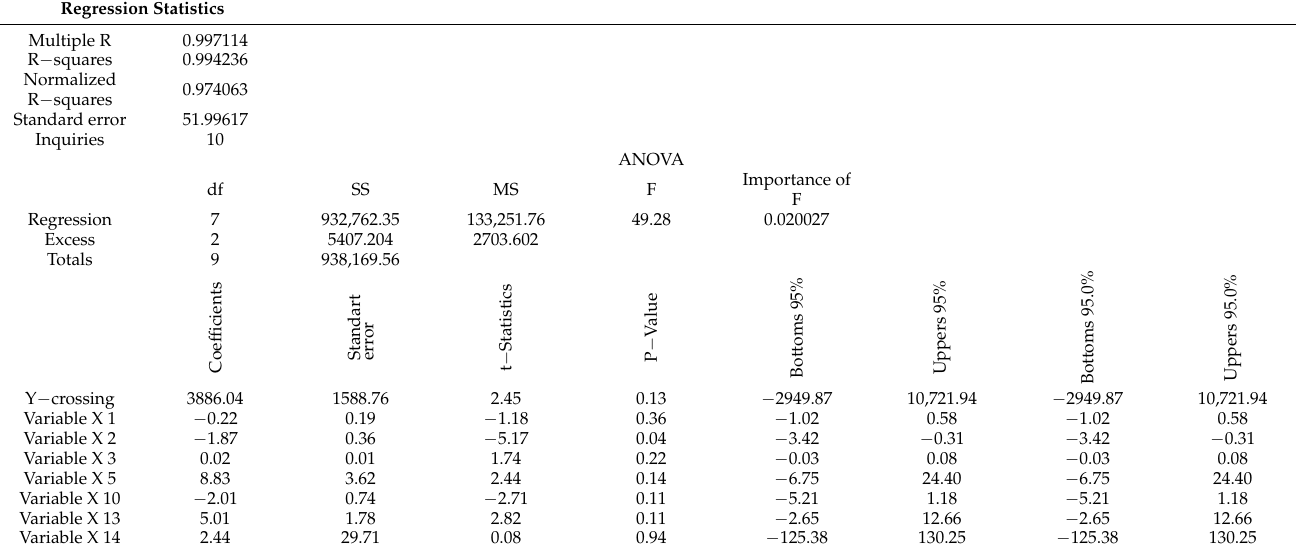
Table 4. Results of the regression